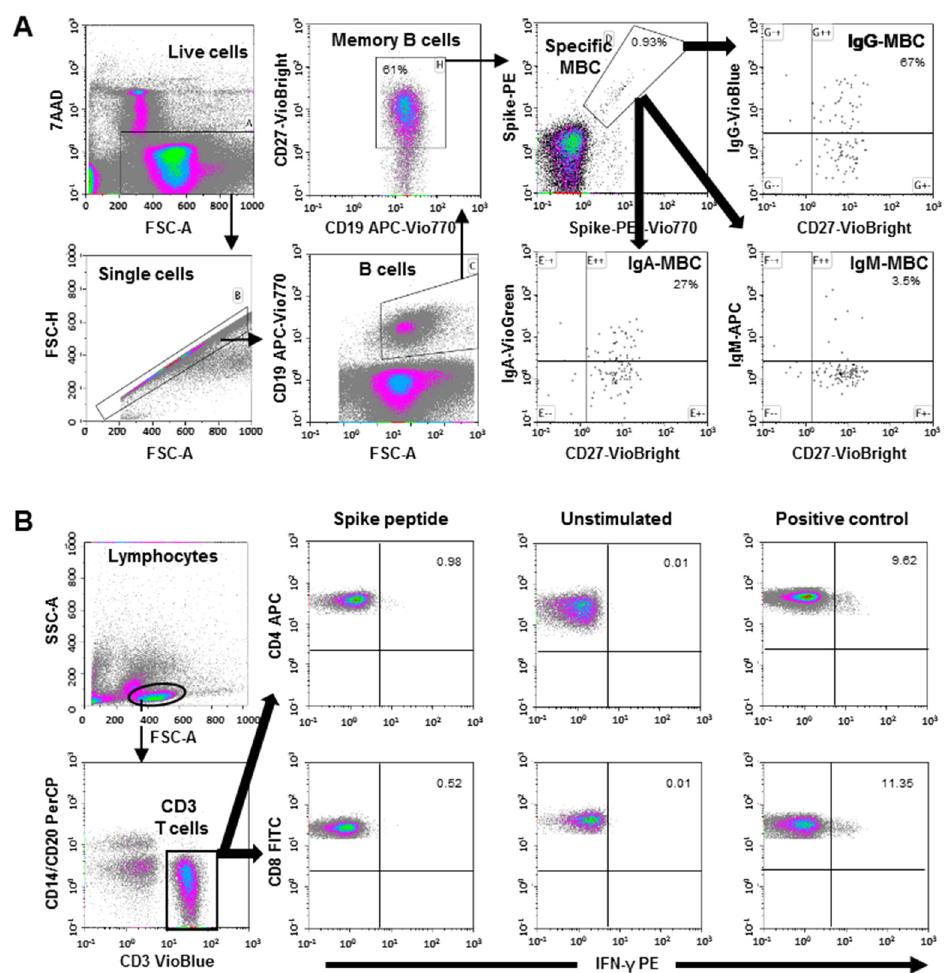
Figure 1. ( A ) Flow cytometry strategy for the quantification of SARS-CoV-2-specific memory B-cells (MBC). Viable cells (FSC-A/7AAA plot) were plotted with FSC-H/FSC-A parameters to exclude doublets. Single cells were then gated using CD19-APC-Vio770 and CD27-Vio-Bright-FITC to identify memory B-cells. Spike-specific B-cells were then identified with a double staining with the two spike-tetramer on the diagonal of the dot plot. Finally, the use of IgG-VioBlue, IgA-VioGreen, and IgM-APC were used to quantify each specific isotype of spike-specific memory B-cells. The results are recorded as percentage among the total memory B-cells and isotypes among specific memory B-cells. ( B ) Flow cytometry gating strategy for the quantification of SARS-CoV-2 spike-specific T-cells. After stimulation with the spike peptide, staining of the cells was carried out with the following fluorochrome-conjugated antibodies: CD3-VioBlue, CD4-APC, CD8-FITC, CD14-PerCP, CD20-PerCP, IFN- γ -PE, and FcR blocking reagent. To exclude dead cells, viability 405/520 fixable dye staining was added for the last 10 min of incubation. The samples were measured and analyzed by flow cytometry on a MACSQuant Analyzer 10 using MACSQuantify software. At least 10 5 cells were analyzed and gated with the following strategy: Single (FSC-A/FSC-H dot plot) and live cells were first selected. Cell debris, monocytes, and B-cells were excluded from the analysis with CD14-and CD20-PerCP antibodies. Then, lymphocytes were selected with an FSC-A/SSC-A dot plot, and CD3 T-cells were gated. IFN- γ expression was finally analyzed separately for CD4+ and CD8+ T-cells. A representative sample of negative control (without stimulation), positive control (stimulated with SEB), and with SARS-CoV-2 spike peptide are shown.